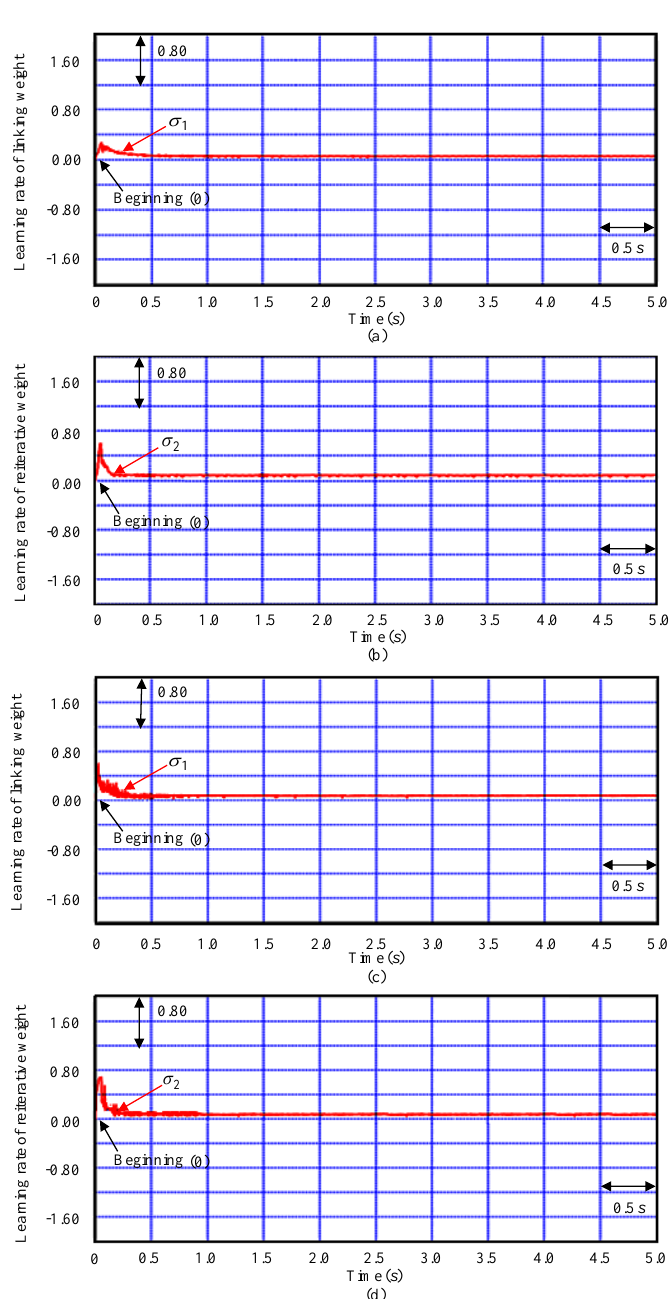
Figure 12. Tested instances with experimental results obtained by using the controller CD3: ( a ) convergent response of learning rate σ 1 of linking weight at the examination Y1 instance, ( b ) convergent response of learning rate σ 2 of reiterative weight at the examination Y1 instance, ( c ) convergent response of learning rate σ 1 of linking weight at the examination Y2 instance, ( d ) convergent response of learning rate σ 2 of reiterative weight at the examination Y2